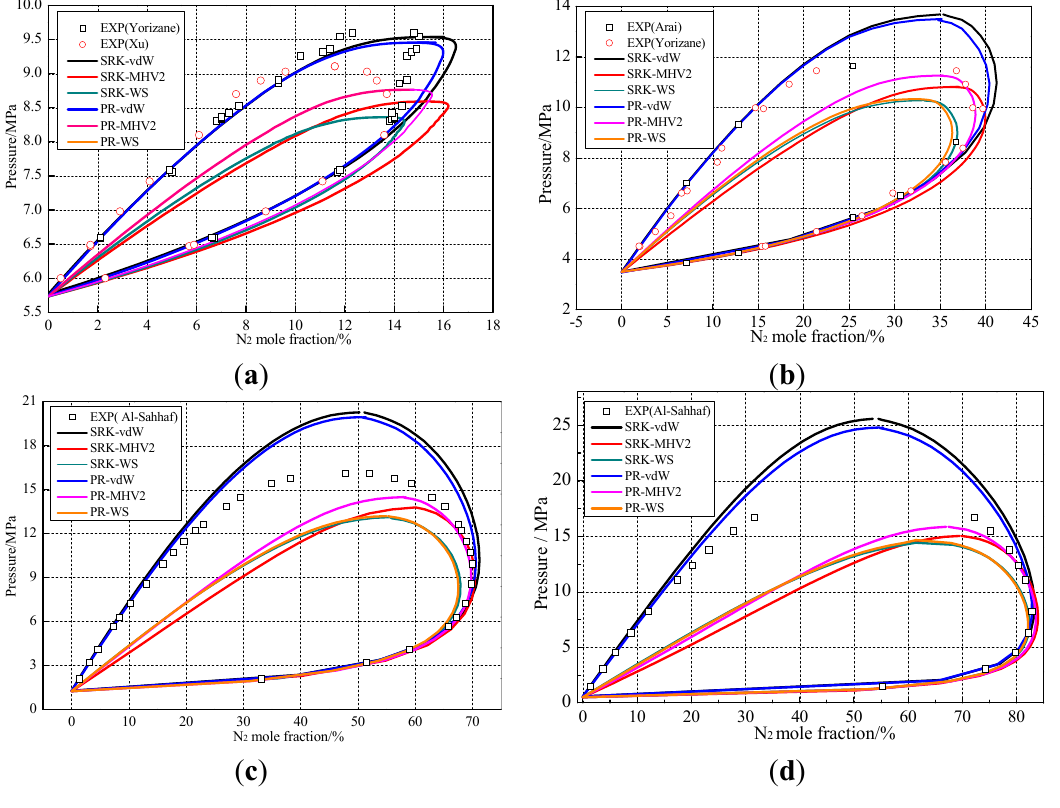
Figure 3. Comparison of varied mixing rules at different temperatures: ( a ) 293.2 K; ( b ) 273.2 K; ( c ) 240 K; and ( d ) 220